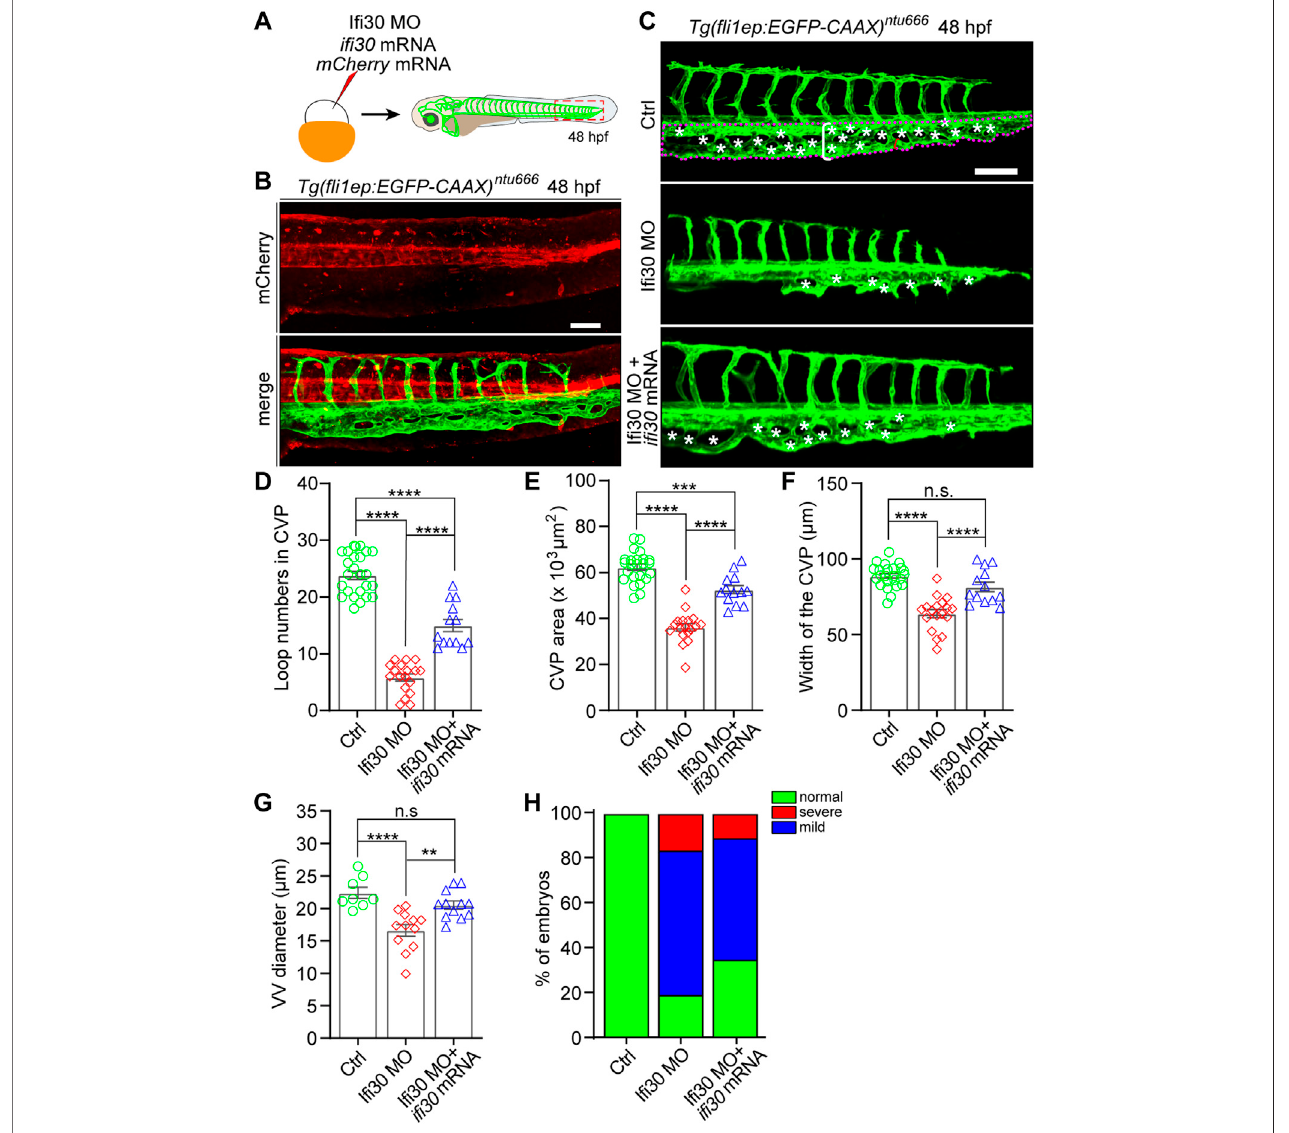
FIGURE 3 | I fi 30 overexpression rescues the defective CVP phenotypes of I fi 30 morphants (A) Schematic representation of the rescue experiment. The mixture of I fi 30 MO, i fi 30 mRNA, and mCherry mRNA is injected into one-cell stage Tg ( fl i1ep:EGFP-CAAX ) ntu666 embryos. The mCherry mRNA is used to verify the working ef fi ciency of mRNA injection by examining the red fl uorescence post injection (B) (C – G) The CVP loop numbers (asterisks), total CVP area (white dotted line outlined area), CVP width (white square bracket), and ventral vein (VV) diameter (red square bracket) in I fi 30 morphants are all rescued by i fi 30 mRNA injection (H) The incidence of normal and defective CVP phenotypes in control Tg ( fl i1ep:EGFP-CAAX ) ntu666 embryos (n = 34), embryos injected with I fi 30 MO (n = 41), and embryos co- injected with I fi 30 MO and i fi 30 mRNA (n = 34). Error bars represent SEM. n. s., not signi fi cant. **, p < 0.01. ***, p < 0.001. ****, p < 0.0001. Scale bars, 100 µm.